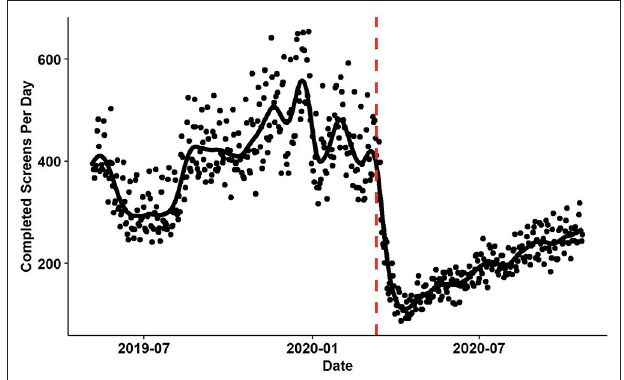
FIGURE 3 | The number of patients screened per day at participating study sites. The red vertical line identifies March 11th, 2020 when the WHO declared the COVID-19 outbreak to be a pandemic. The black fit line was computed using smoothing splines. The λ parameter was set using generalized cross